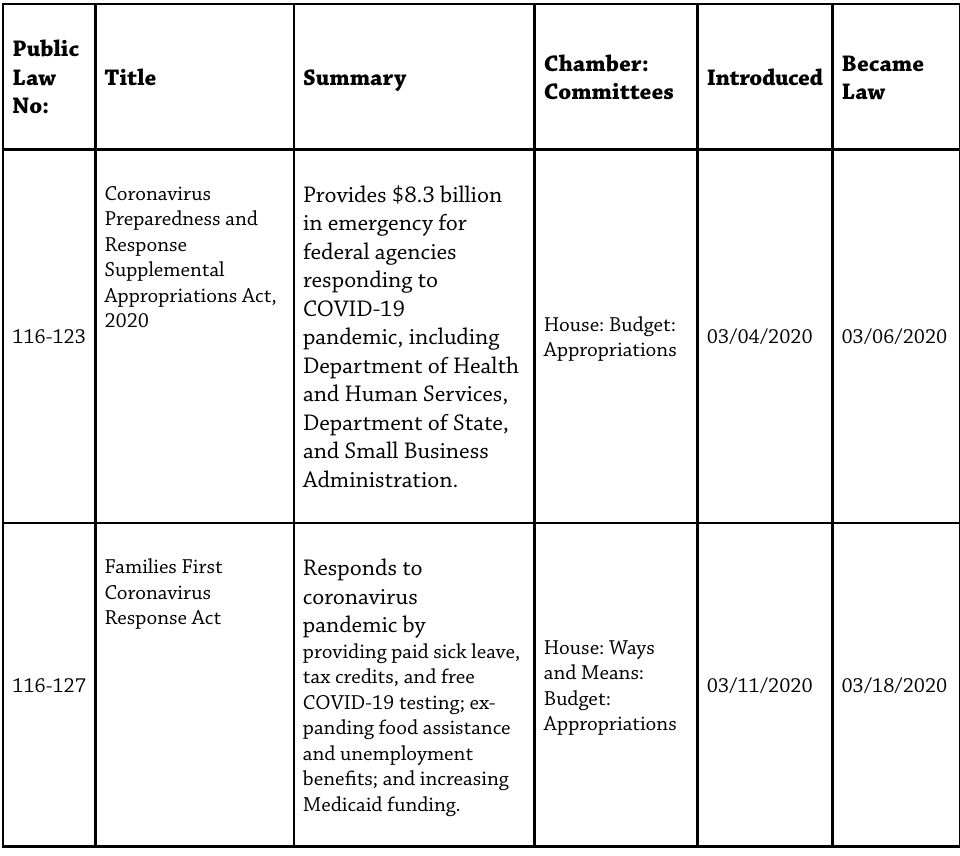
Table 4: Federal Legislation Enacted in Response to COVID-19